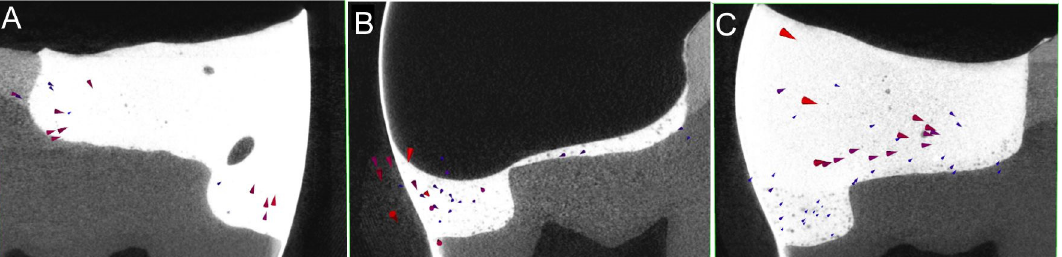
Figure 3. The shrinkage vectors point in the direction of mass movement upon polymerization of resin composites. Bulk application of a bulk-fill composite resulted in an upward movement at the gingival margin of the proximal box ( A ). The application of a thin flowable liner ( B ) below the bulk application of a hybrid bulk-fill composite resulted in smaller shrinkage vectors in the proximal box and yielded a more favorable shrinkage movement toward the tooth–restoration interface ( C ); image reprinted with permission from Kaisarly et al., published by Elsevier 2022 [93] .